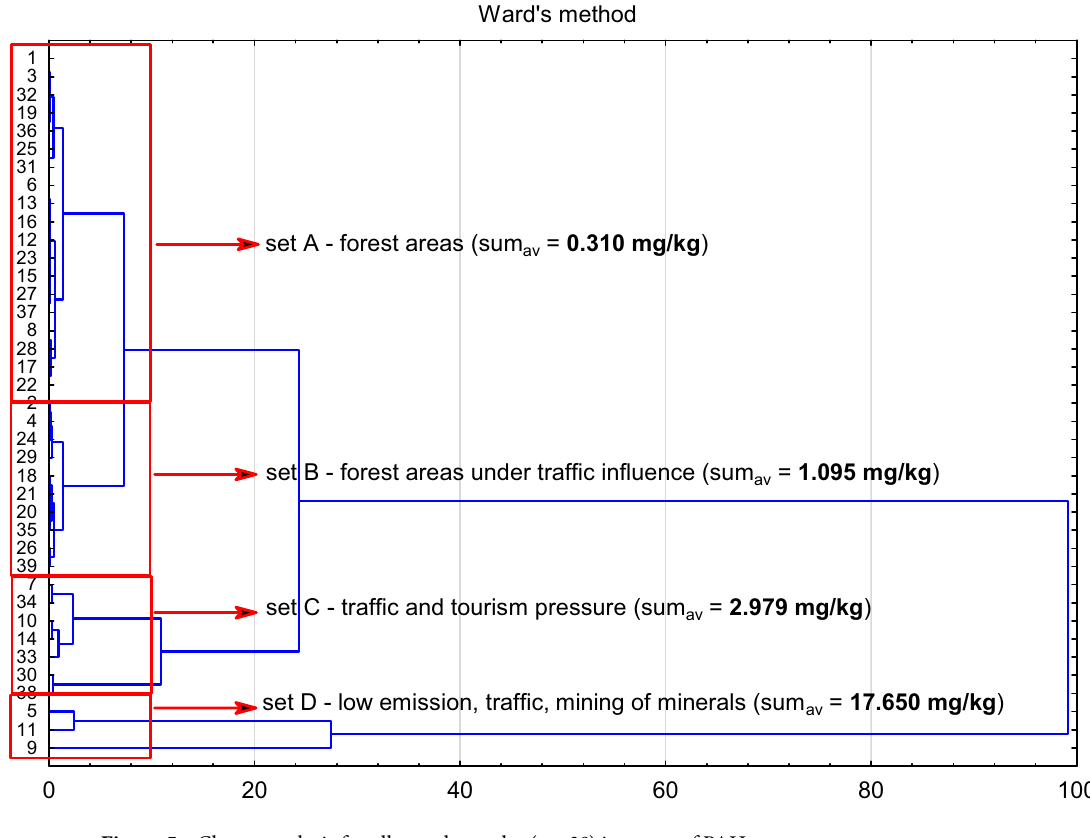
Figure 5. Cluster analysis for all tested samples ( n = 39 ) in terms of PAH